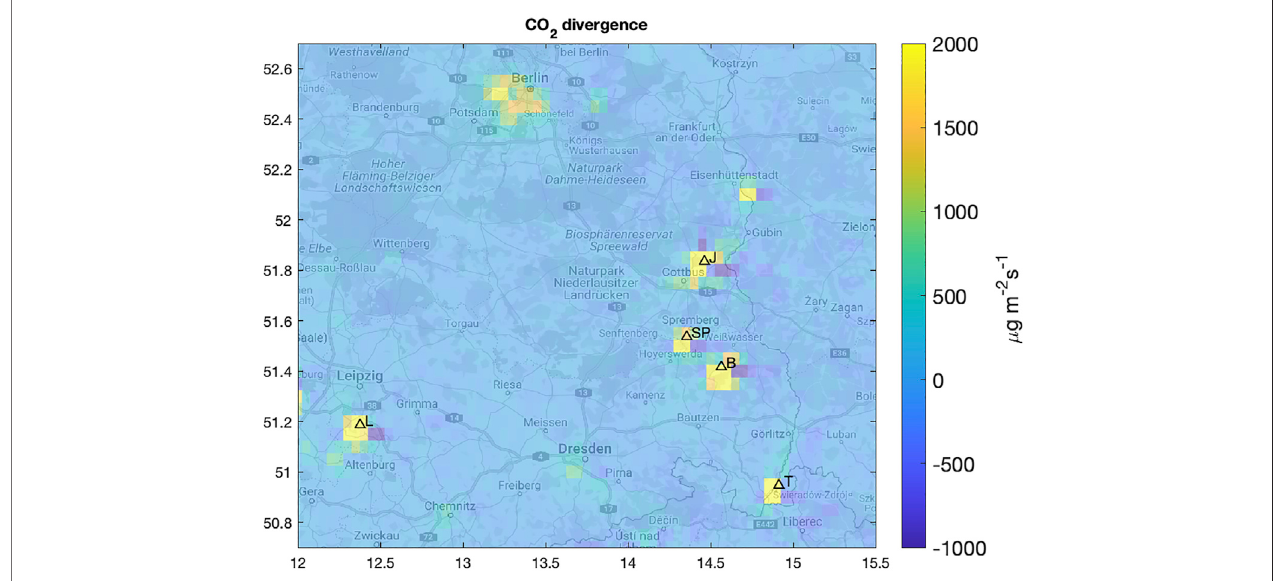
FIGURE2| CO 2 divergencecalculatedfromtheCOSMO-GHGmodelsimulations.Onlyanthropogenicenhancementsareconsidered.Positivevaluescorrespond tostrongemissionssourcessuchaspowerstations(Boxberg,Jänschwalde,Lippendorf,SchwarzePumpe,andTurówmarkedwithB,J,L,SP,andT,respectively)and the city of